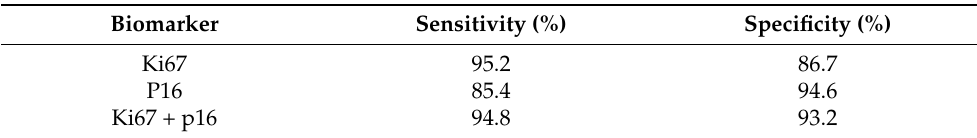
Figure 3. Diagnostic scheme for some HIV-associated cancers using specific biomarkers. The above diagram represents the use of the expression levels of p53, Ki-87 and MIB-1 proteins as well as the presence of HPV-DNA as diagnostic biomarkers. The expression levels of p53 can be used to diagnose Kaposi’s sarcoma (suppressed) and cervical cancer (elevated) [43,125]. The diagnosis of cervical cancer can be confirmed by the increased presence of HPV DNA as well as elevated levels of Ki-67 and MIB-1. While elevated levels of KI-76 and MIB-1 with no effects on p53 or presence of HPV DNA can serve as diagnostic markers for Non-Hodgkin lymphoma, the presence of HPV DNA without the increase of p53, Ki-67 or MIB-1 is indicative of anal cancer [34,63,139]. Table 5. Ki67 and p16 biomarkers enhance each other to improve cervical cancer sensitivity Table 4. Biomarkers used to diagnose different stages of cancers (Cervical cancer). and